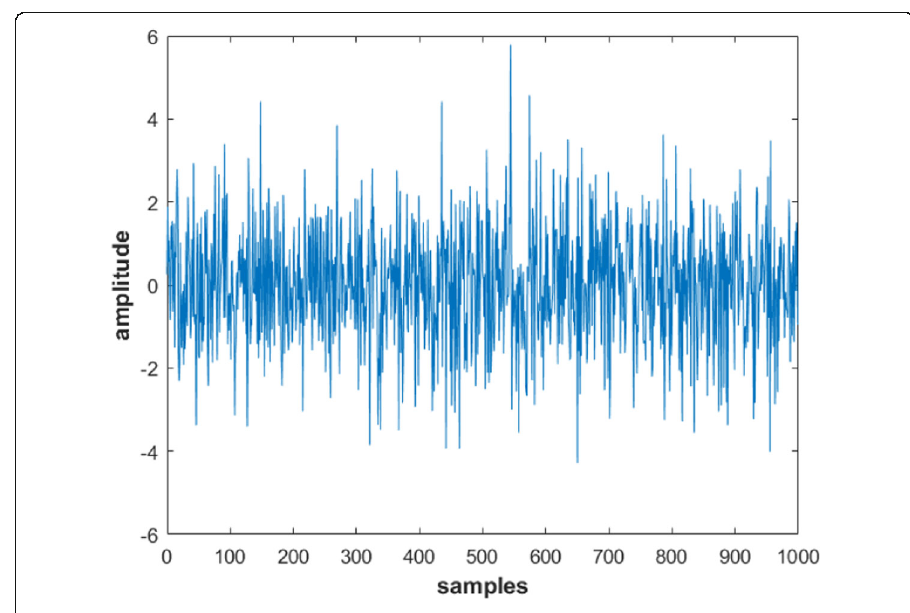
Fig. 3 S α S distributed signal with α =